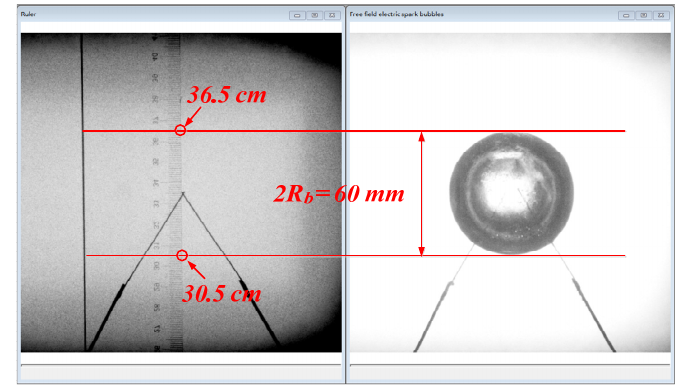
Figure 5. Schematic diagram of the method for measuring the bubble diameter.